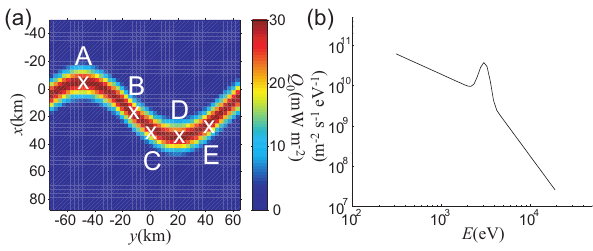
Fig. 3. (a) Spatial distribution of total energy flux ( Q 0 ) of inci- dent electrons at 230-km altitude. Top and right correspond to the northward and eastward direction, respectively. The cross marked A indicated the line-of-sight direction of the EISCAT radar. (b) En- ergy distribution of incident electrons at point A. The distribution was produced in almost the same way as Strickland et al. (1993).